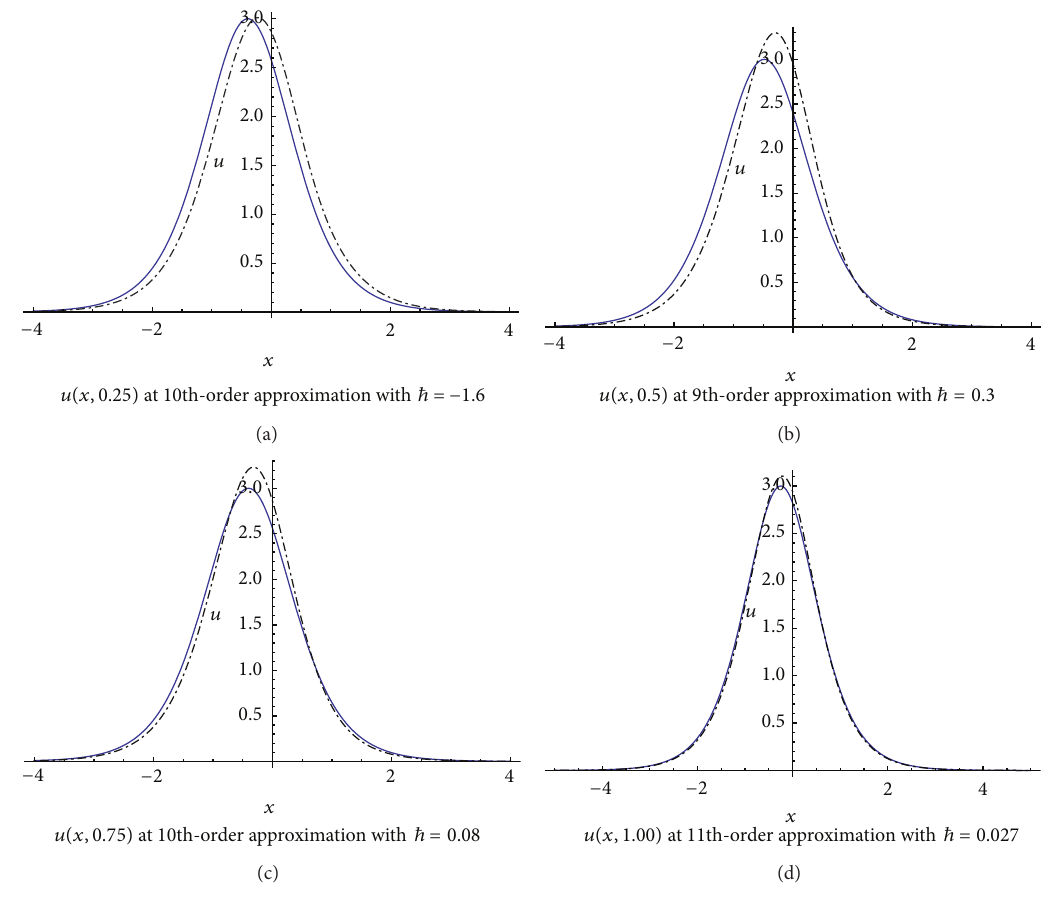
Figure 8: MATHEMATICA © graphs depicting 𝑢(𝑥, 0.25) , 𝑢(𝑥,0.50) , 𝑢(𝑥,0.75) , and 𝑢(𝑥,1) against 𝑥 . Solid line is for analytical solution of [3], and dash line is the HAM